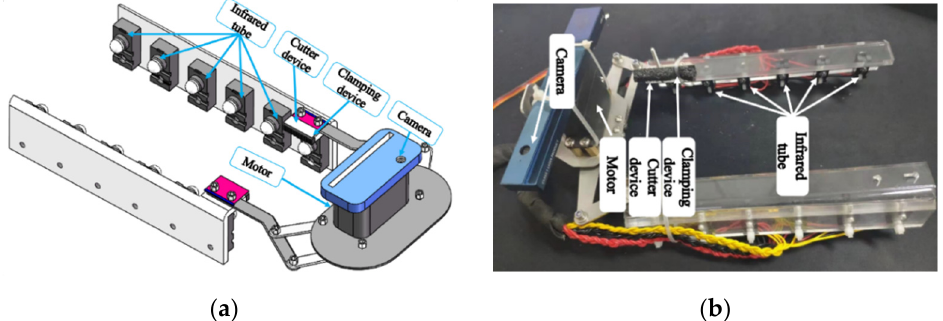
Figure 6. Detection and picking device structure drawing. ( a ) Structure image. ( b ) Physical image.